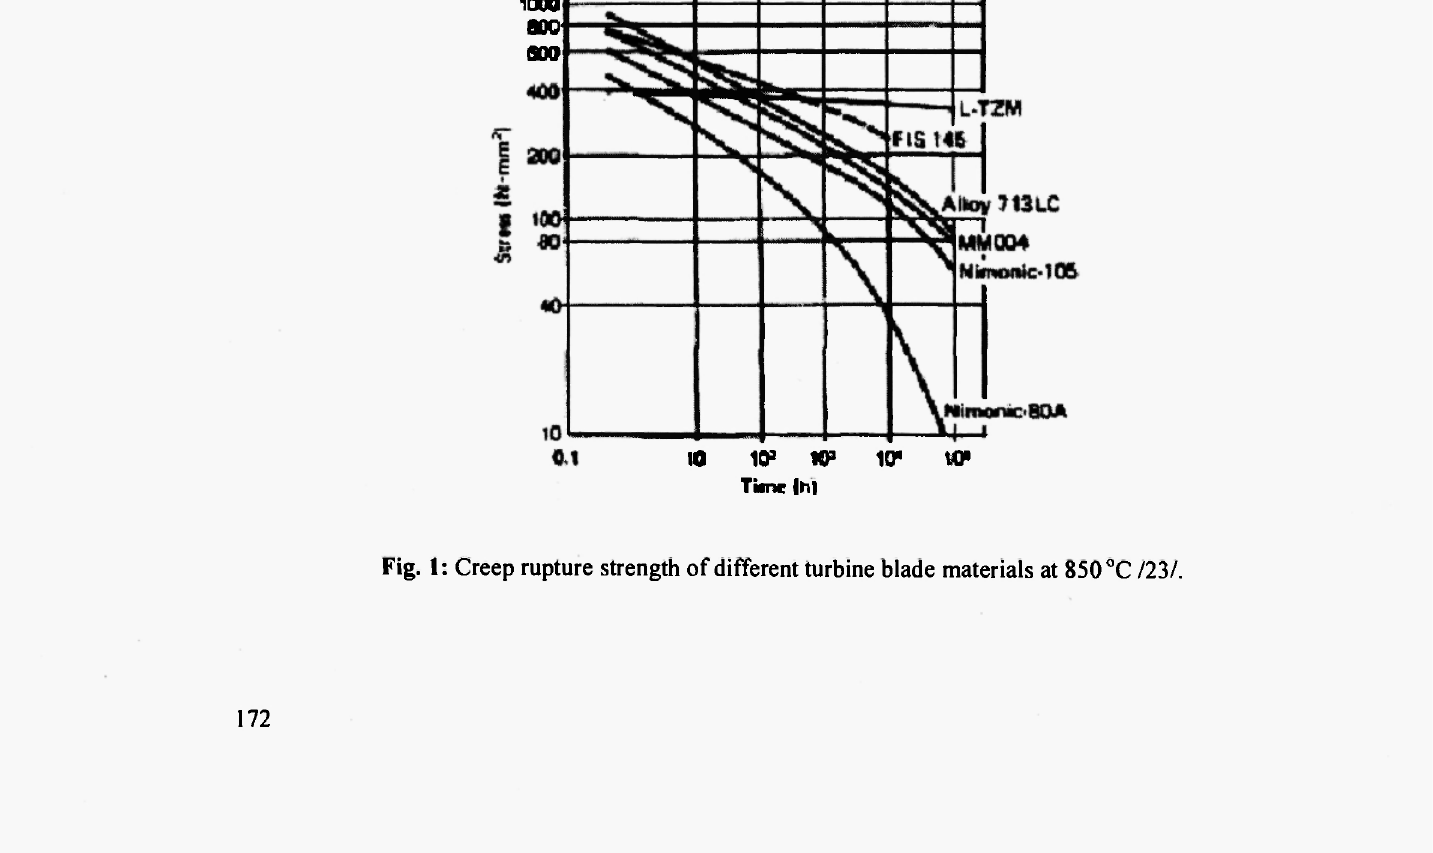
Fig. 1: Creep rupture strength of different turbine blade materials at 850 °C